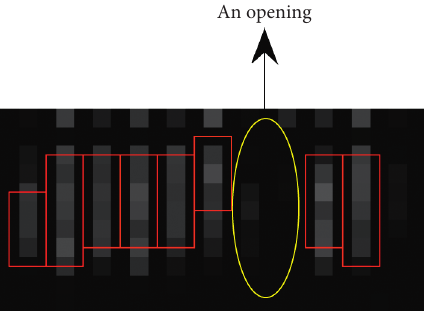
Figure 8: The detection result of Figure 5(c) by the improved DoG filter.